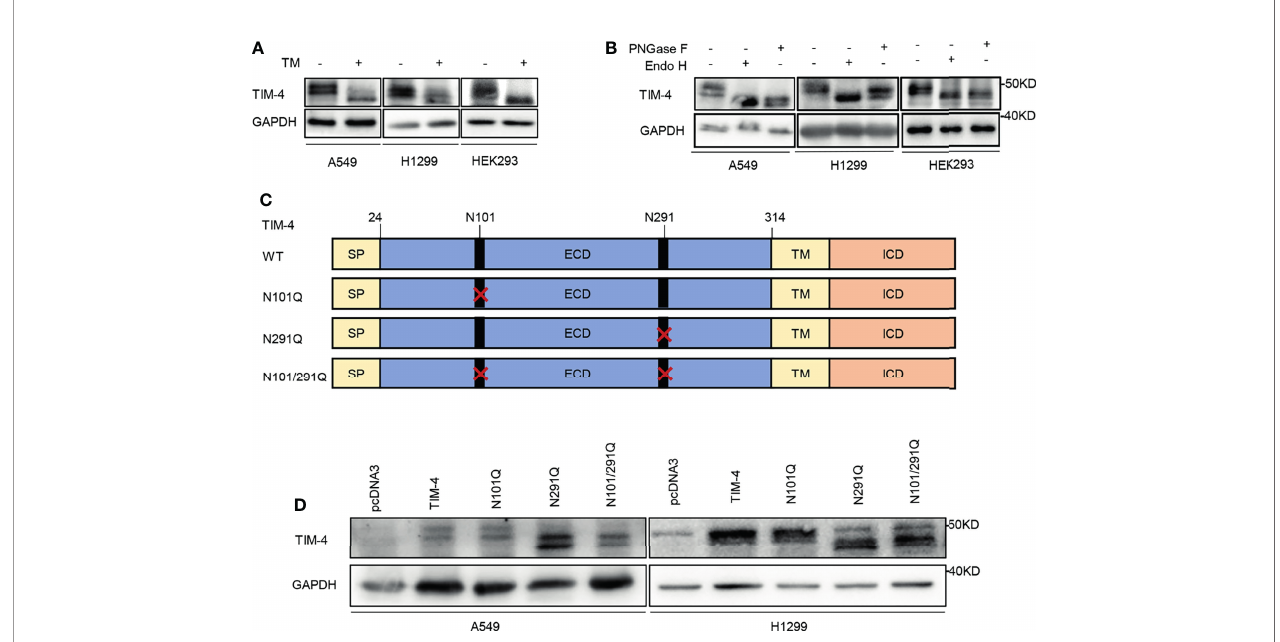
(C) Design of mutated plasmid at the N-glycosylation sites of TIM-4. (D) Western blot analysis of the protein expression pattern of WT TIM-4 and N291Q